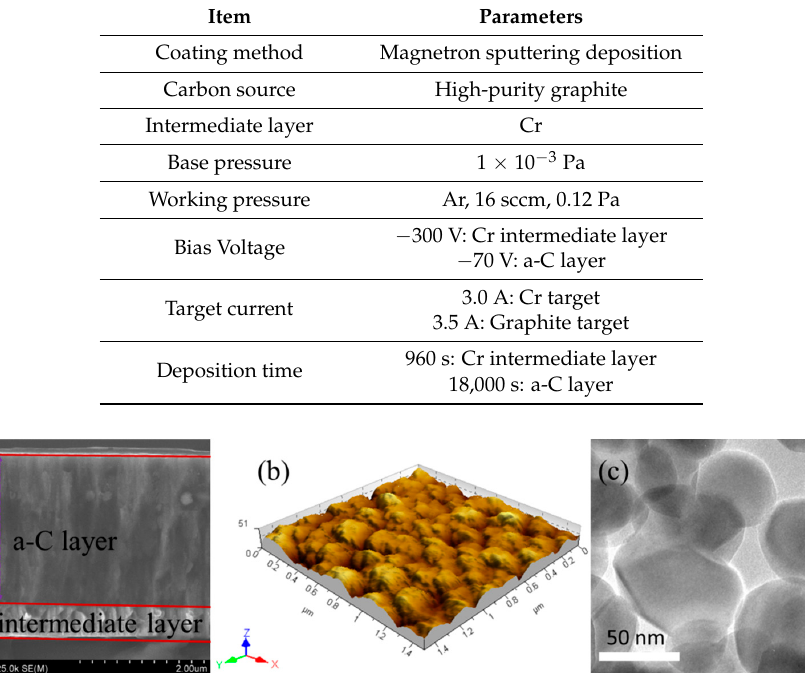
Table 1. The process parameters for coating deposition.